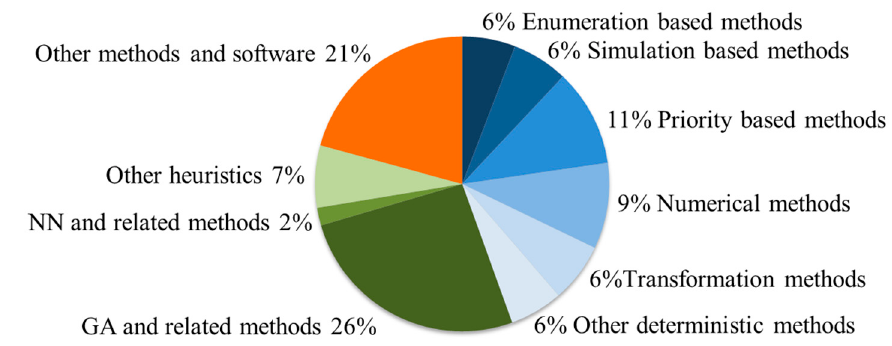
Figure 6. Optimization methods applied by the reviewed articles.